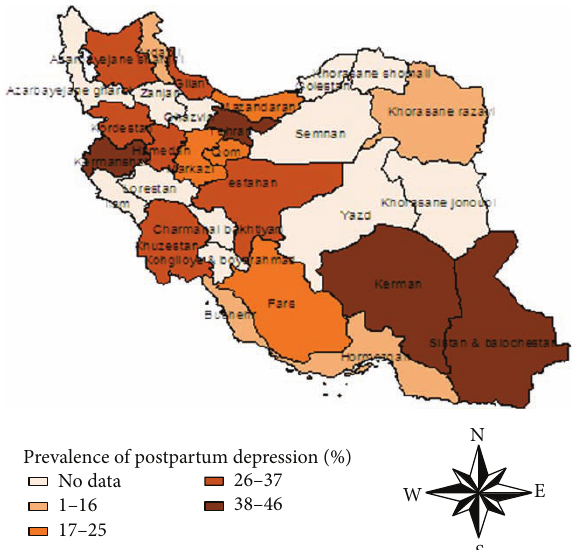
Figure 3: Regional distribution of pooled prevalence of postpartum depression in Iran.